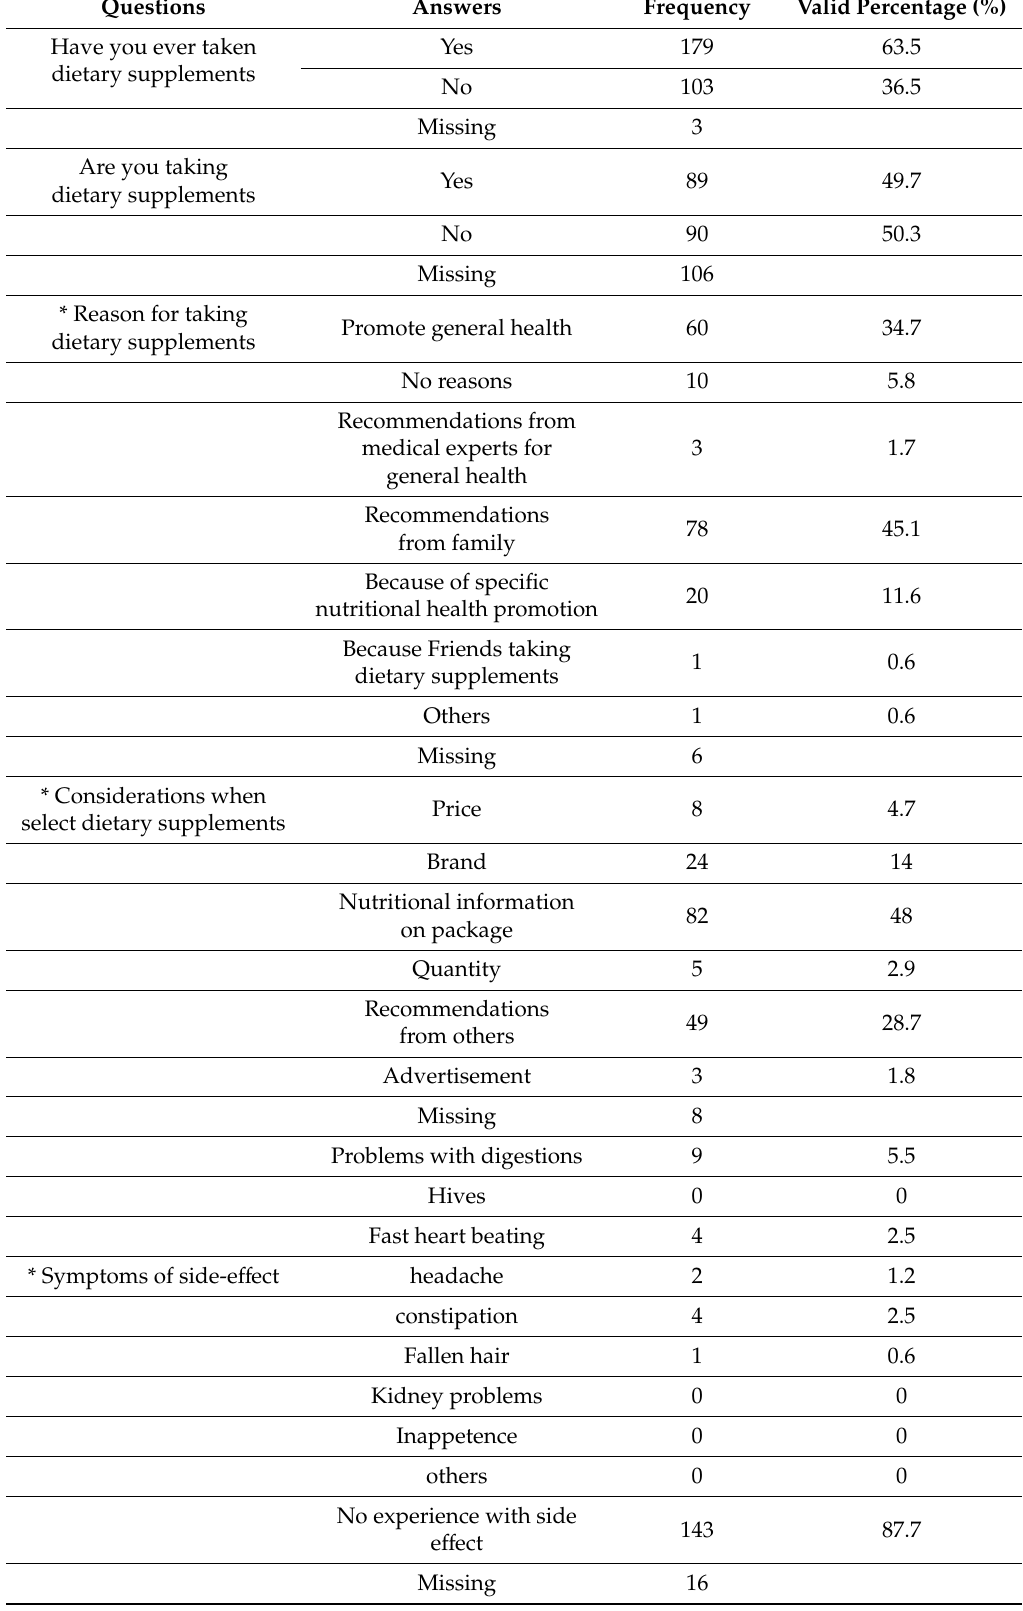
Table 2. General Dietary Supplement Consumption